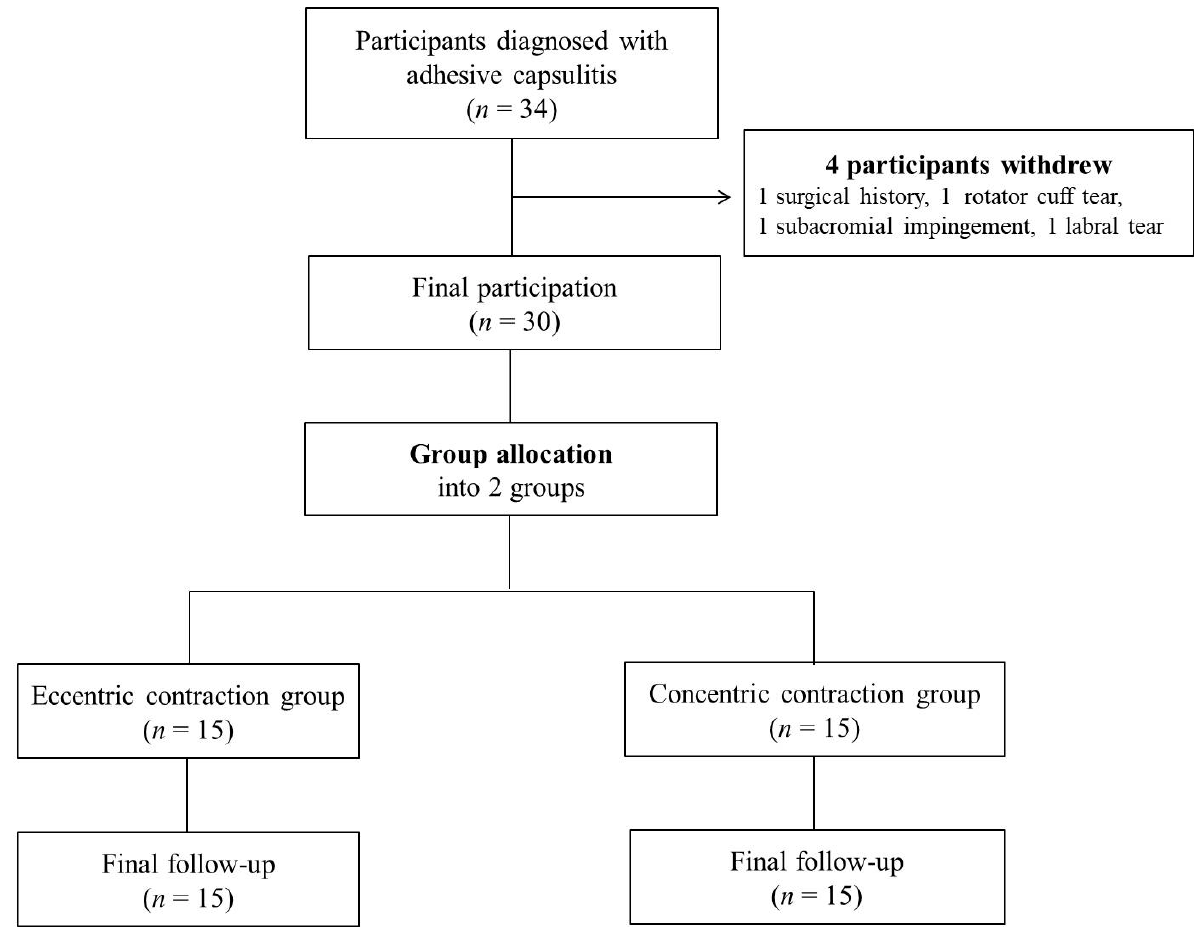
Figure 1. Flow chart of this study.